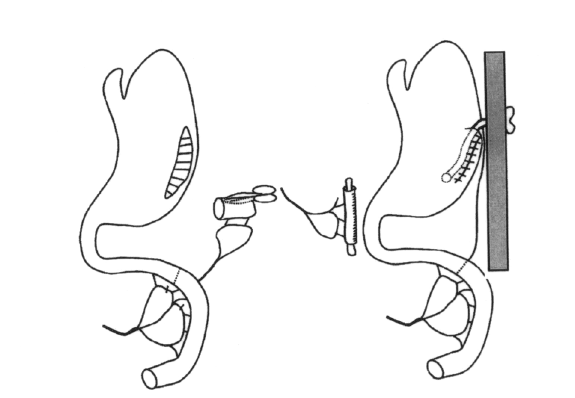
Figure 2 – Schematic drawing of surgical technique in the study group.